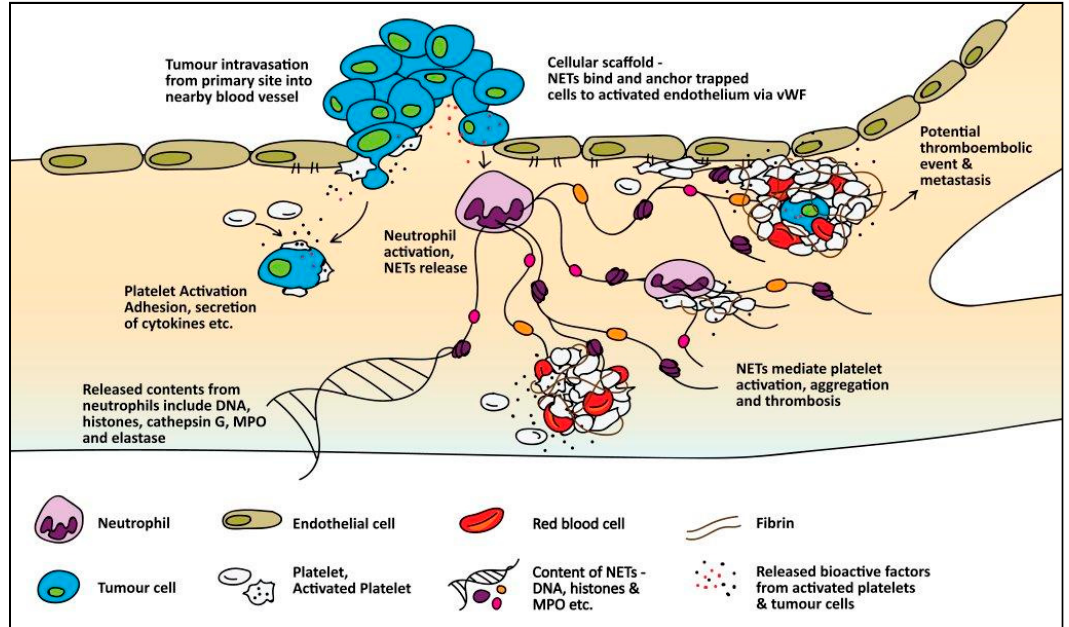
Figure 2. Indirect mechanisms promoting thrombosis in cancer. Tumours can be highly metastatic, resulting in cancer cell dissemination and intravasation into nearby blood vessels. Inflammatory cytokine secretion from tumour cells can cause activation of platelets and promote a procoagulant phenotype in endothelial cells. Cancer-derived factors also stimulate neutrophils to release neutrophil extracellular traps (NETs). NETs serve as a scaffold that can physically entrap platelets, or activate platelets through NET-associated histones, ultimately leading to profound platelet activation, fibrin deposition, and entrapment of red blood cells, exacerbating clot